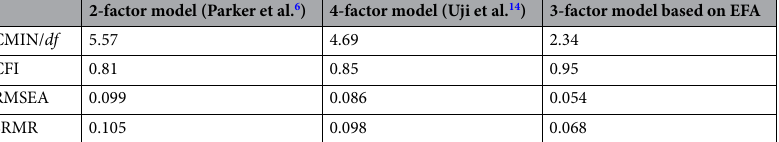
Table 8. Fit indices of different models. χ 2 : Chi-squared; df : Degrees of freedom; CFI: Comparative fitness index; SRMR: Standardized root mean square residual; RMSEA: Root mean square error of approximation.